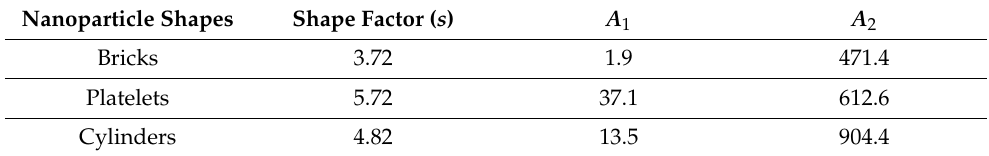
Figure 3. Variations in the velocity profiles for ( a ) the Hartmann number, ( b ) Grashof number, ( c ) Helmholtz – Smoluchowski velocity and ( d ) shape factor.